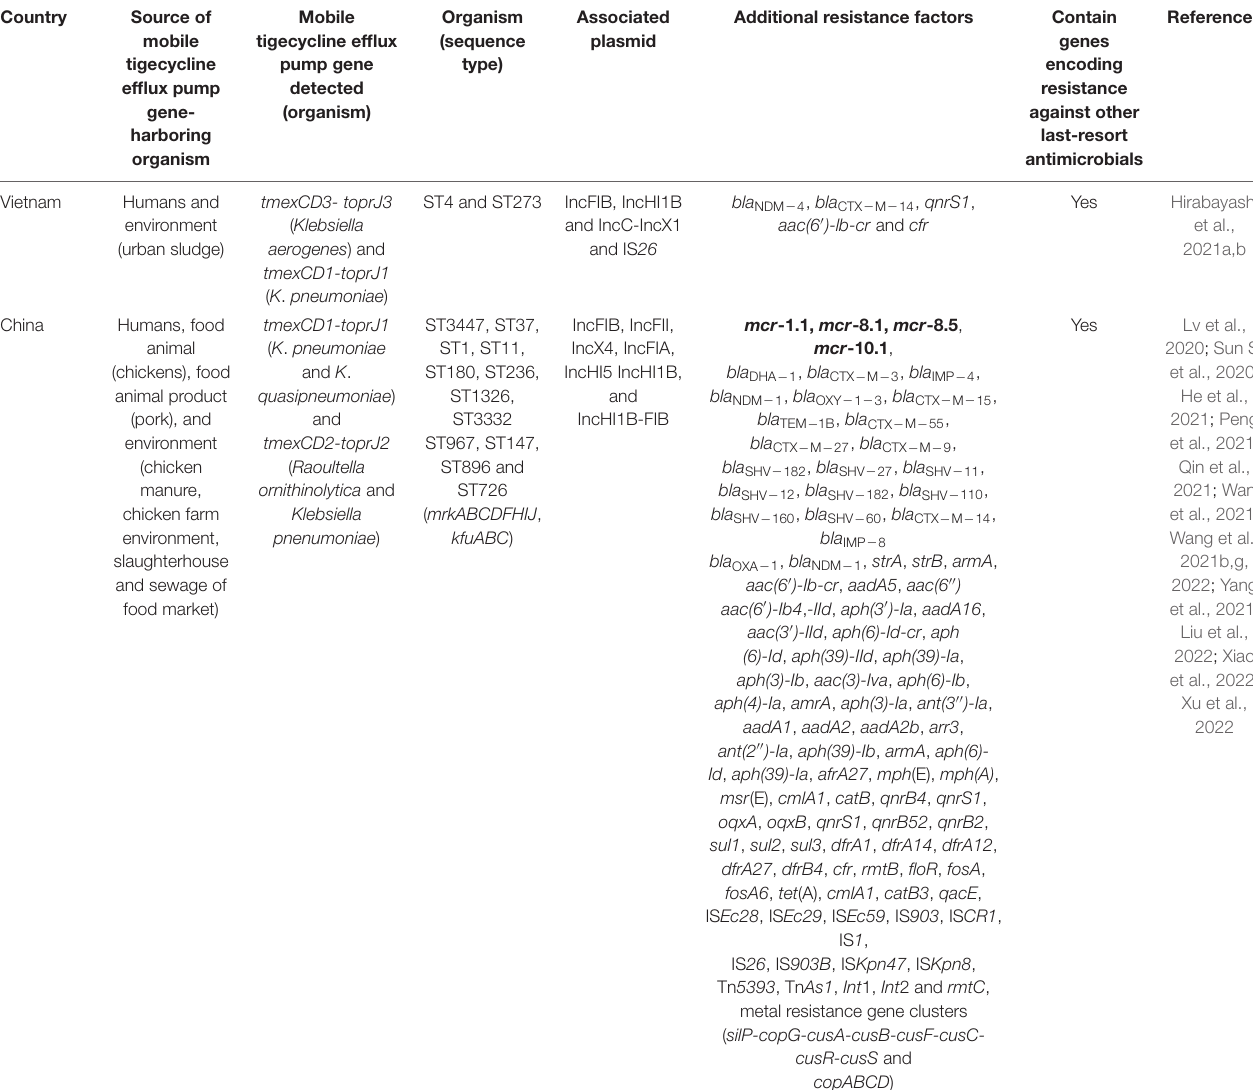
TABLE 3 | Ecological niches in which plasmid-mediated high-level tigecycline resistance efflux pump gene have been detected.